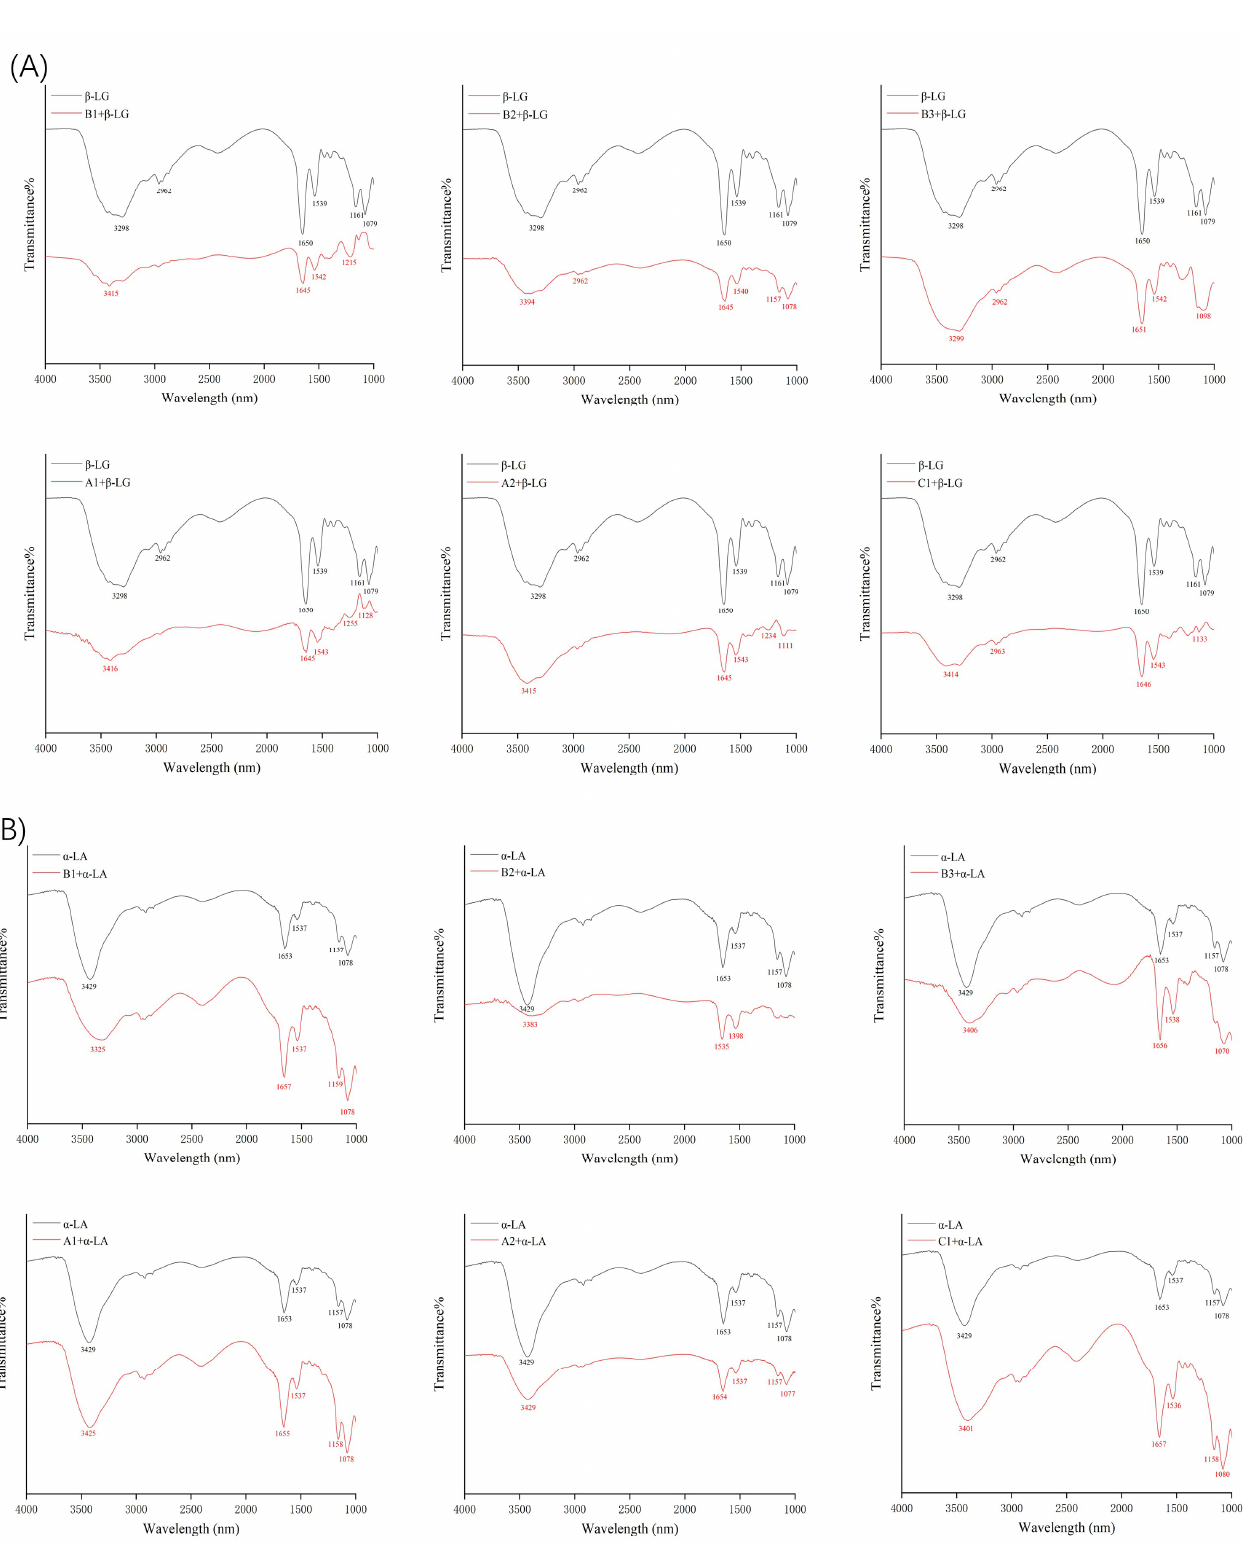
Figure 4. FTIR spectroscopy of β -LG ( A ) or α -LA ( B ) in the presence and absence of proanthocyanidins A1, A2, B1, B2, B3, and